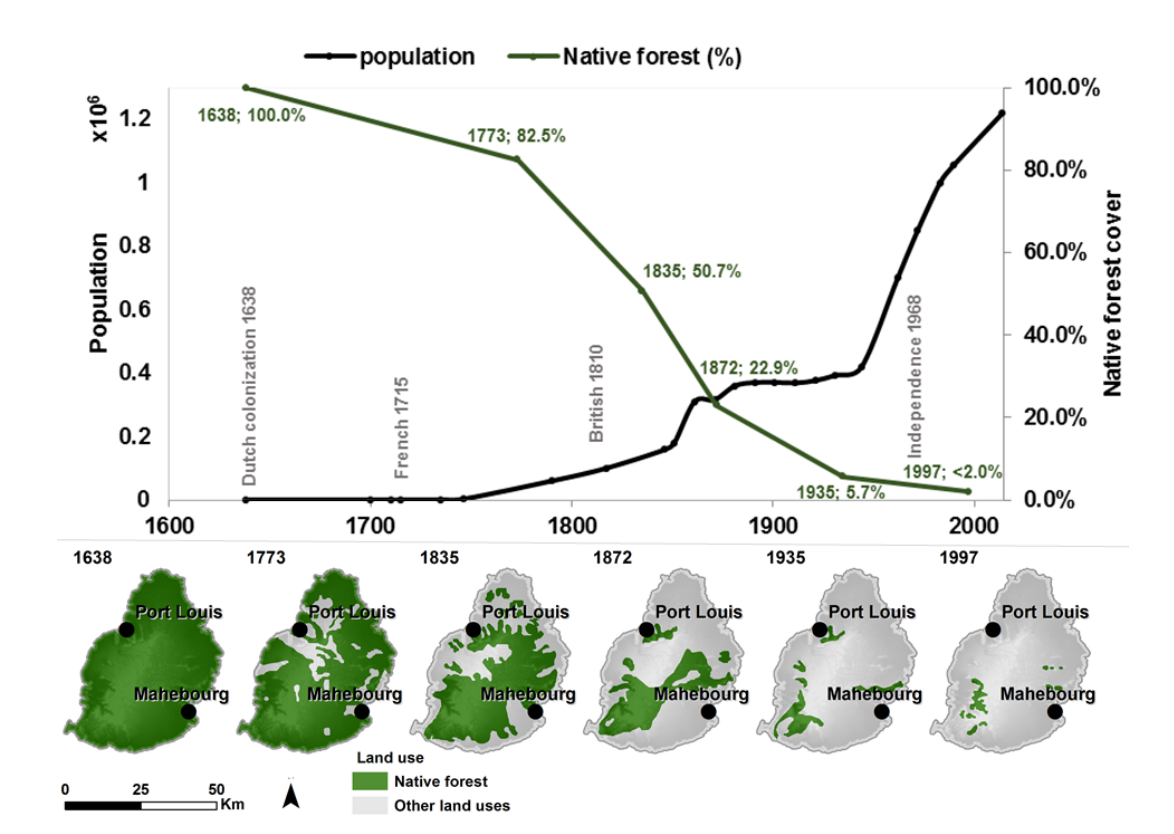
Fig. 2. Population growth and deforestation on Mauritius since human colonization (upper panel). Population graph based on Koenig (1944), Titmuss and Abel-Smith (1960), Lutz and Wils (1994), and Statistics Mauritius (2015 a ), percentage of native forest cover from Florens (2013). The lower panel shows six timeslices indicating the areas where native forest was removed since colonization in 1638. The six maps are based on Vaughan and Wiehe (1937) and references therein, and Page and D’Argent